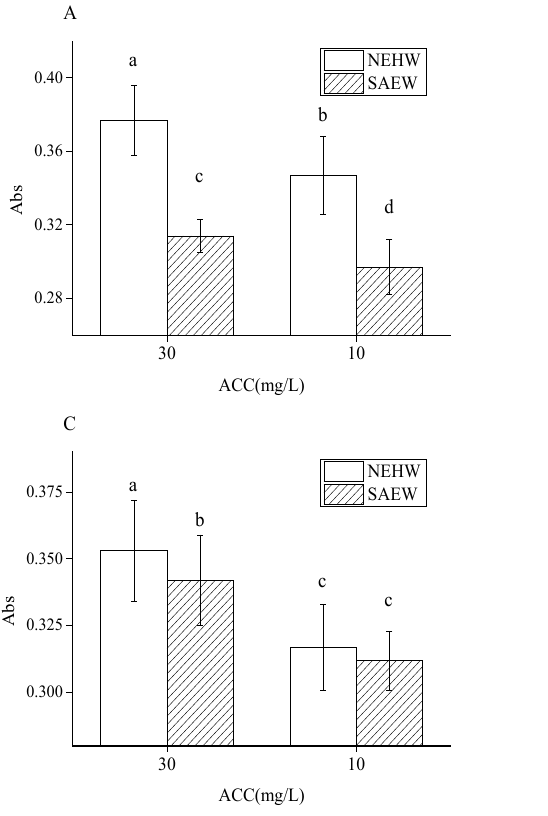
Figure 3. The detection of hydroxyl radical content by NEHW and SAEW under 30 and 10 ACC. ( A ) is the crystal violet detection method, ( B ) is the salicylic acid detection method, ( C ) is the methylene blue detection method. The different letters indicate significant differences ( p <